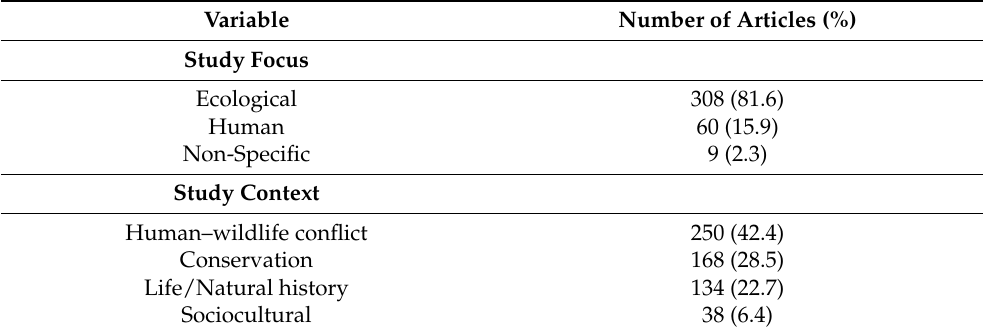
Table 2. Frequency of study focus and context within the reviewed human-raptor interaction